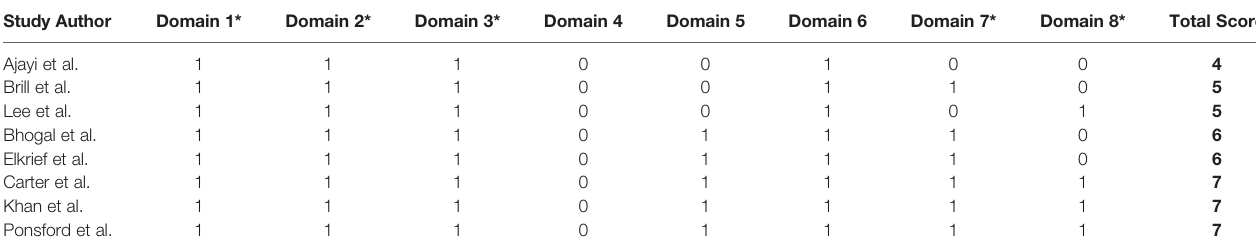
TABLE 2 | Risk of bias assessment - cohort studies (n =